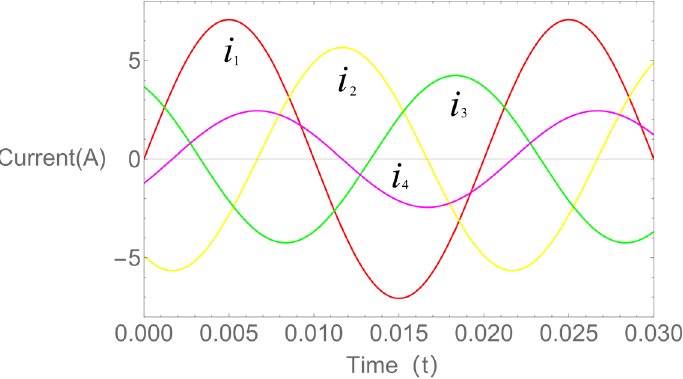
Figure 7. Reduction current curve.